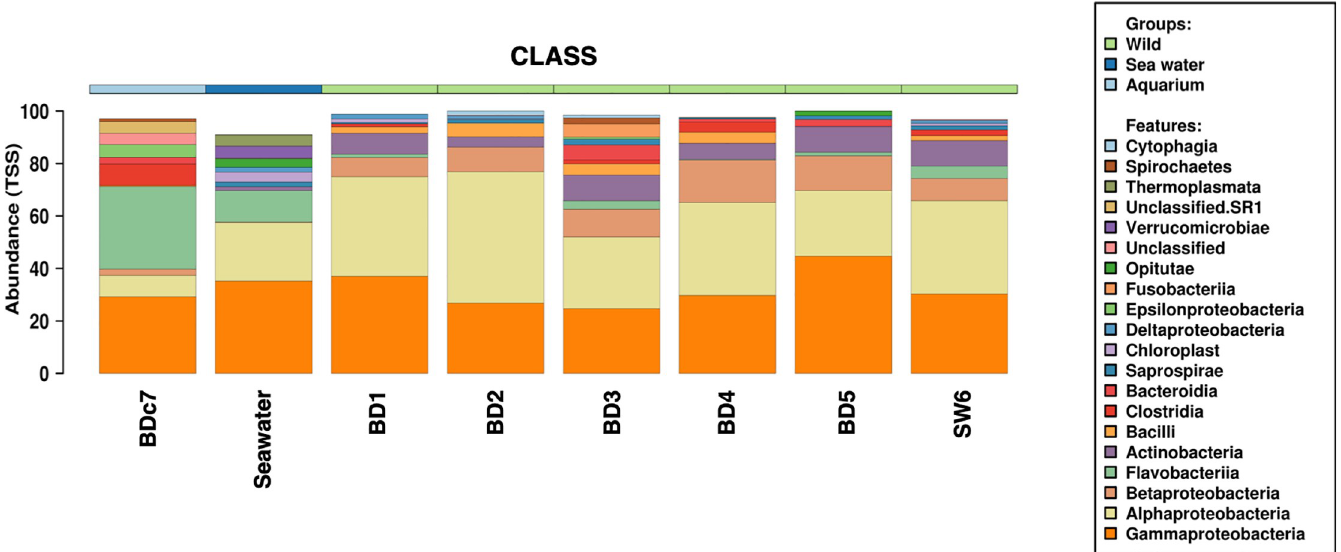
Fig 5. Bacterial community composition. Bacterial community composition at Class level in blow from wild bottlenose dolphins, the one under human care bottlenose dolphin, sperm whale and seawater.